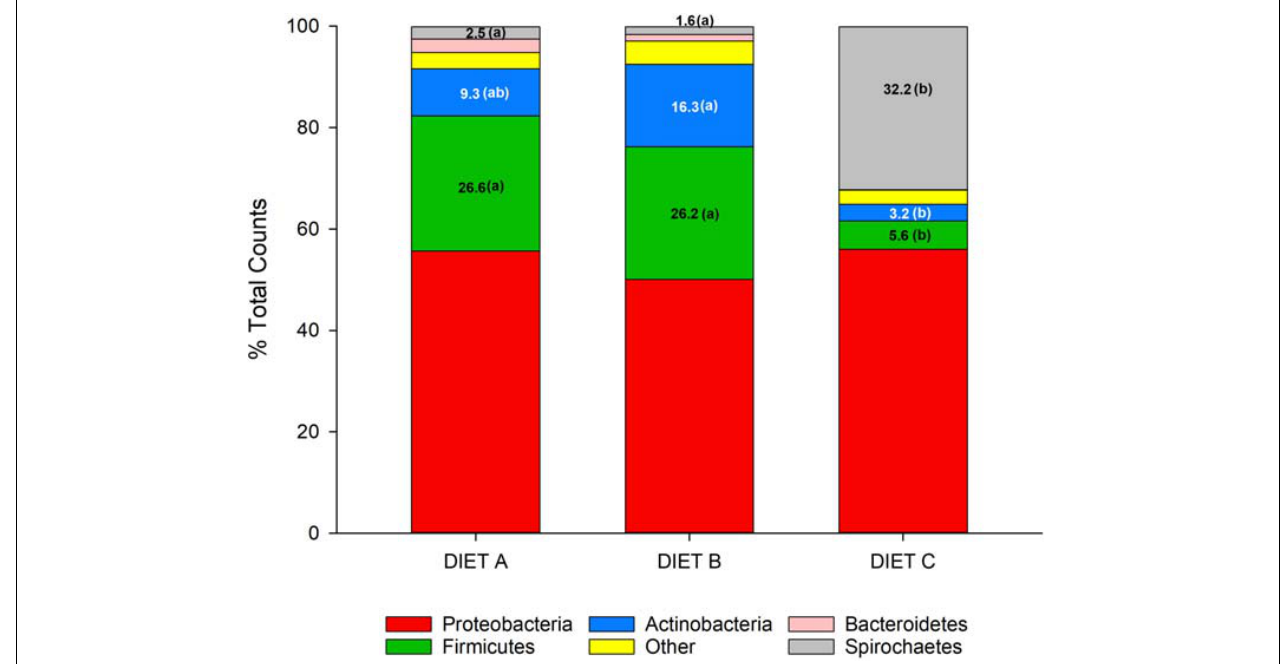
FIGURE 4 | Stacked bar chart representing the relative abundance (%) of bacterial phyla in fish fed control (A) and experimental (B and C) diets. The Kruskal–Wallis test (Dunn’s post hoc test, P < 0.05) showed significant differences between groups for the phyla Firmicutes, Actinobacteria and Spirochetes. The differences are indicated by different letters in parenthesis that correspond to pairwise comparisons within each phylum between